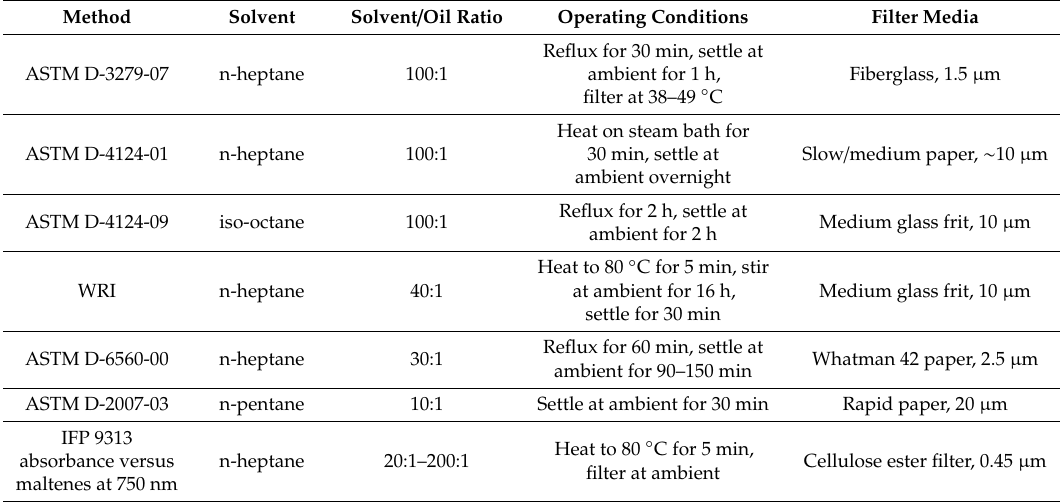
Table 1. Variety of asphaltene precipitation